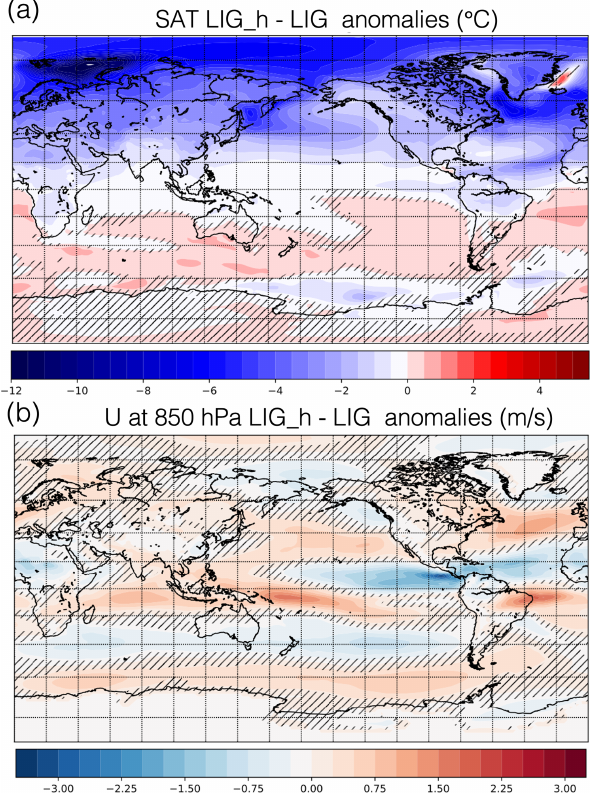
Figure 4. LIG_hosing–LIG surface air temperature (SAT) anoma- lies (a) and zonal mean U at 850hPa anomalies (b) . Non-hatched areas correspond to statistically significant differences (at 95% con- fidence).